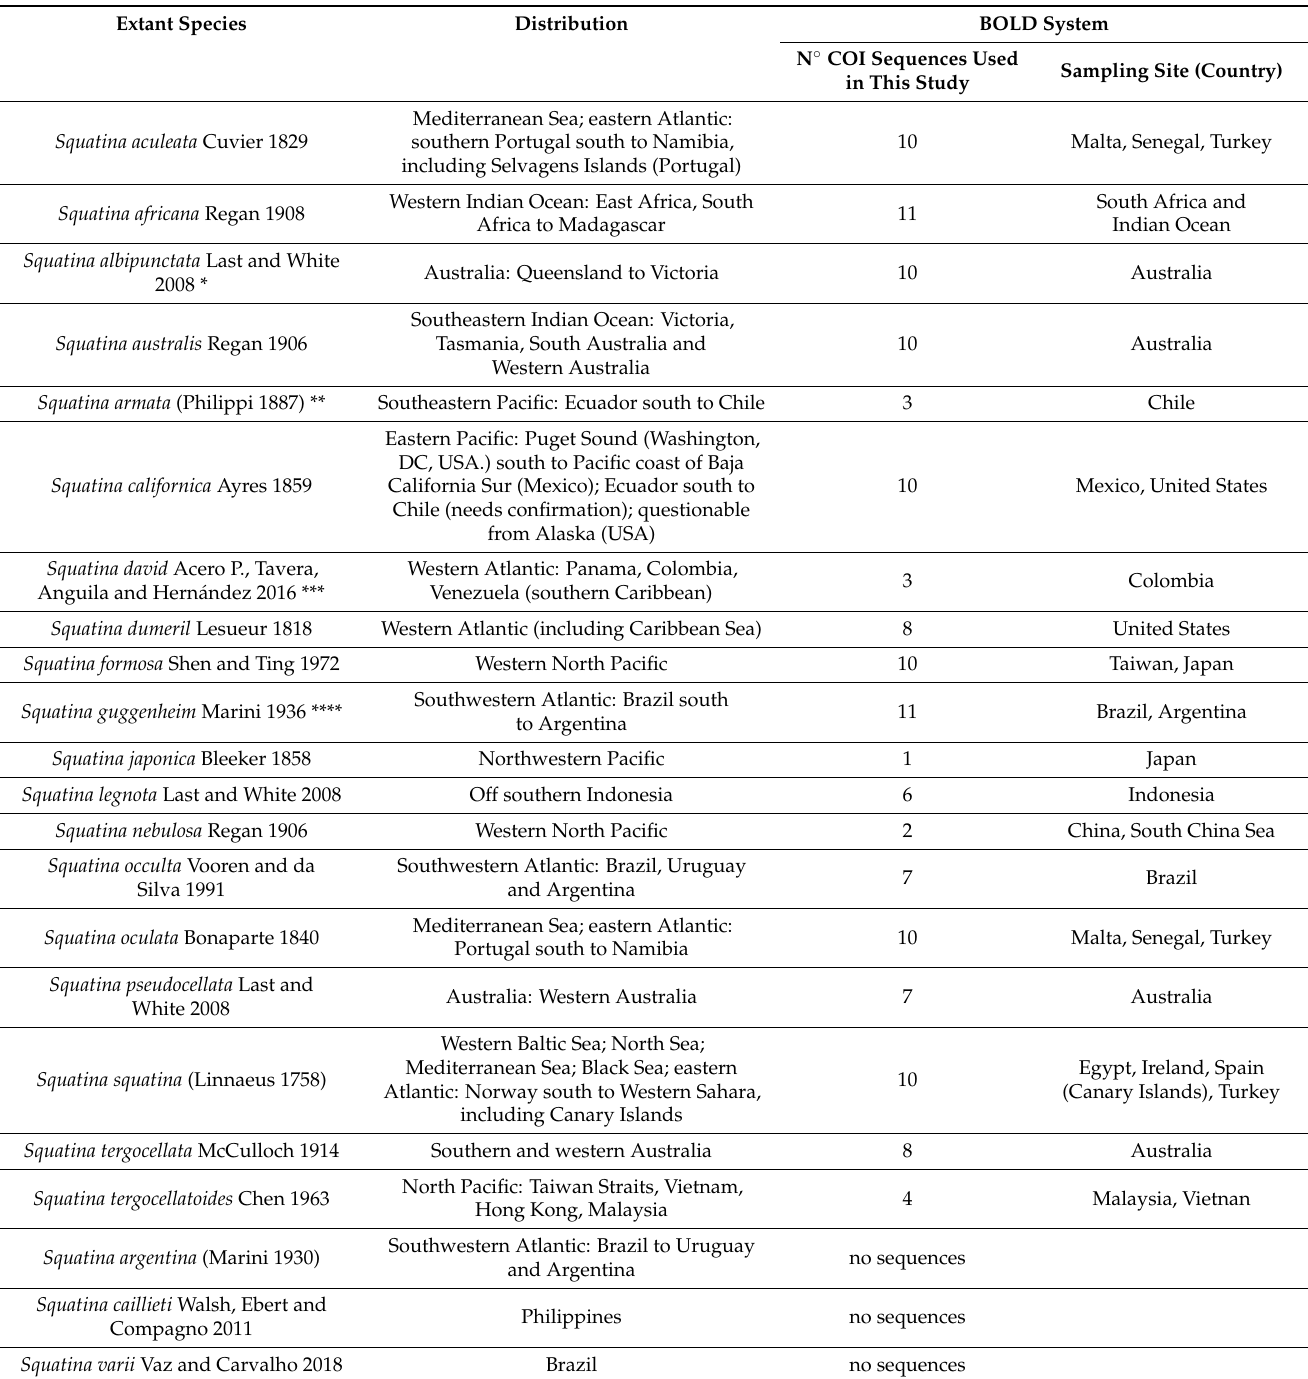
Table 2. List of extant species, their current distribution (Fricke et al., 2020), number of COI sequences used in this study per species, and sampling sites reported in BOLD System per species. See Table S1 for detailed